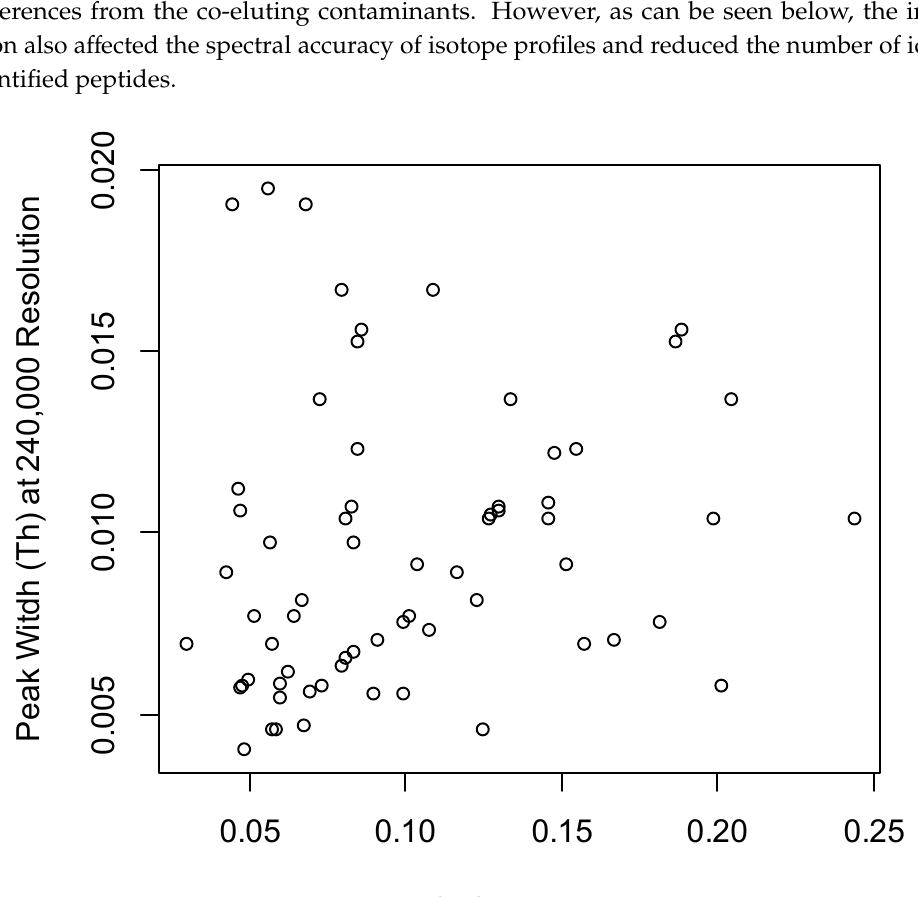
Figure 2. For the increased resolution, the peak widths were smaller. The scatter plot of peak width computed by d2ome for the serum Albumin peptides quantified at 30,000 (x-axis) and 240,000 (y-axis) resolutions. The ratio of the means of the peak widths was 10.5.